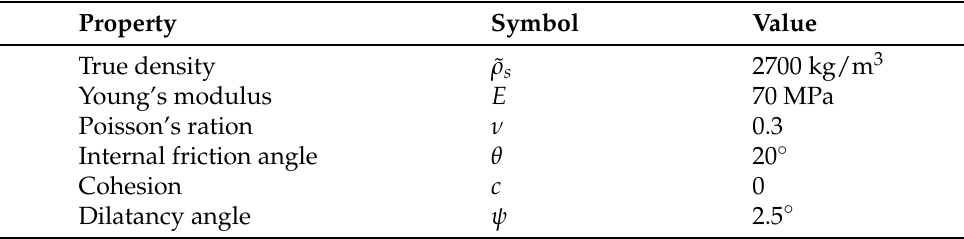
Figure 3. Dry granular column collapse in air. Table 1. Properties of the granular material used in the computation for an initially 10 cm × 10 cm ( L i × H i ) dry granular column collapse in